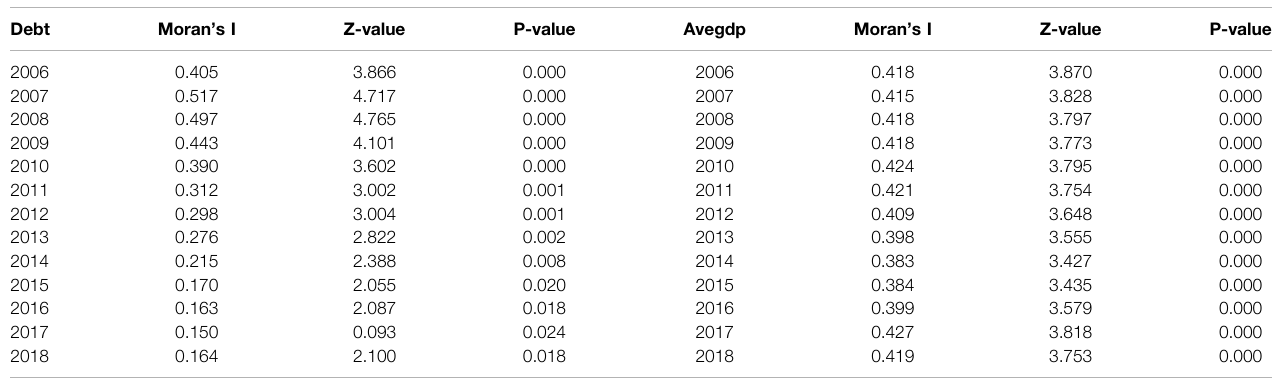
TABLE 2 | Global Moran index of local government debt and per capita GDP (2006 –